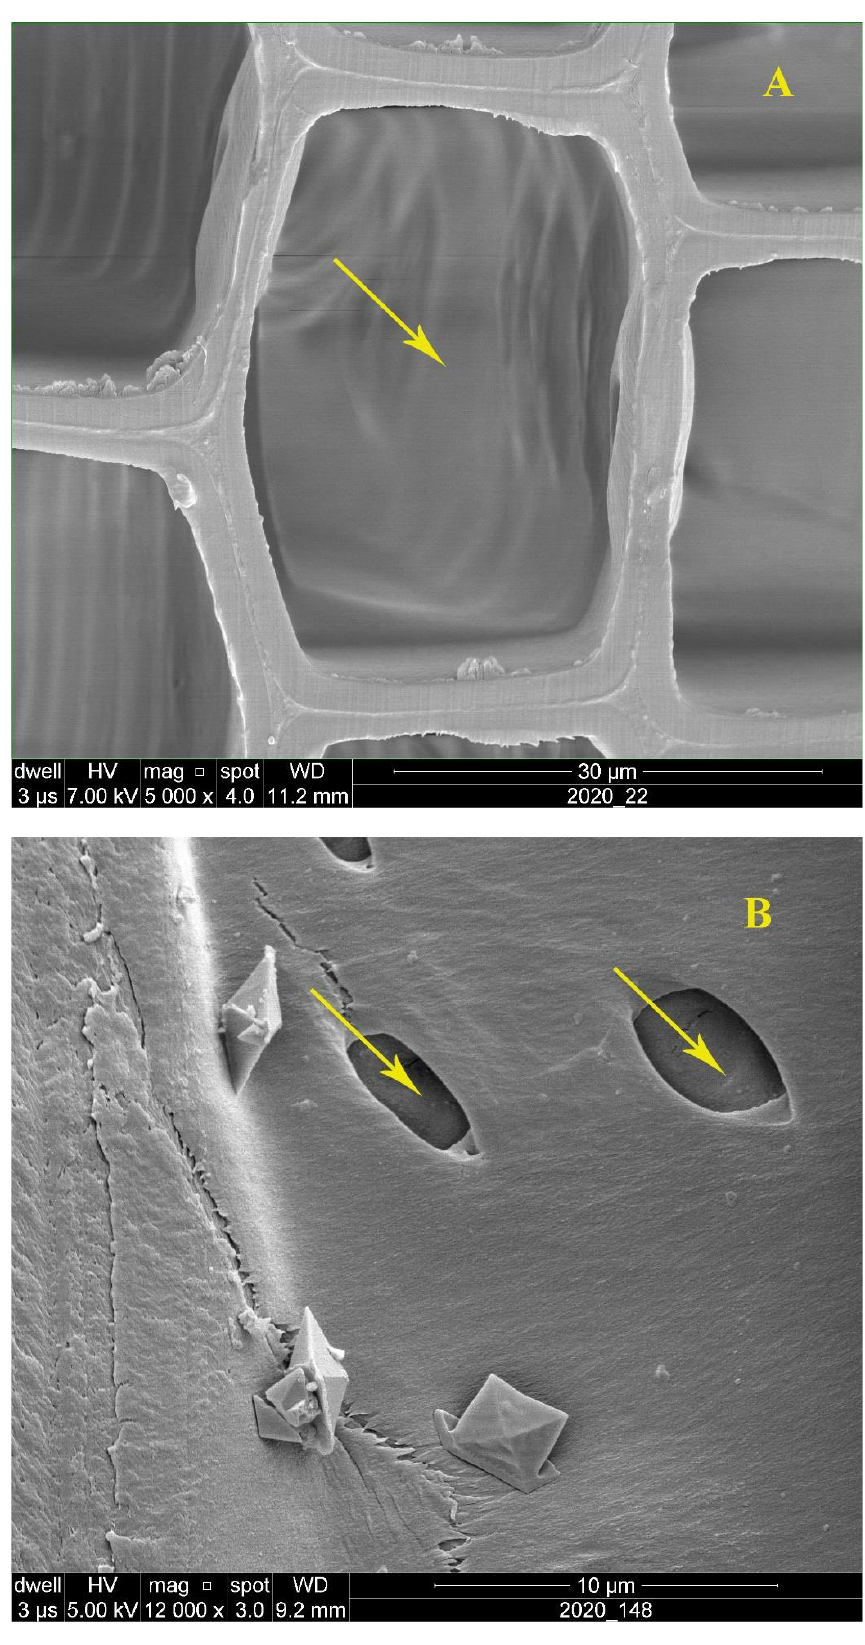
Figure 4. SEM image showing tracheid lumen in the cross-section of fir wood ( A ) and pits in the cell wall in the lateral section ( B ) ( ↑ ).